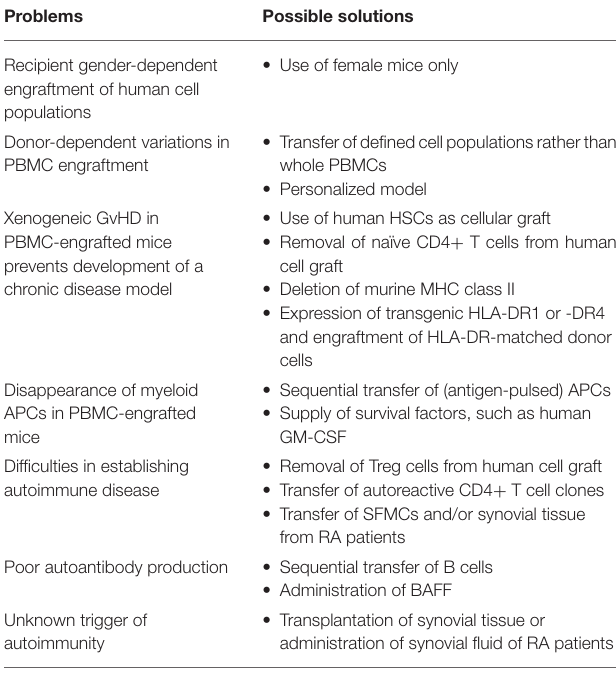
TABLE 2 | Challenges of recapitulating rheumatoid arthritis in chimeric humanized mice. Problems Possible